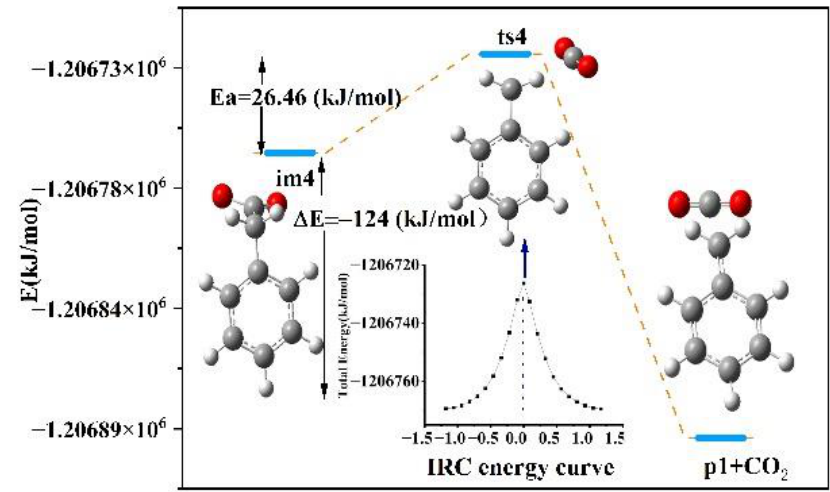
Figure 8. Activation energy of CO 2 generated by aldehyde